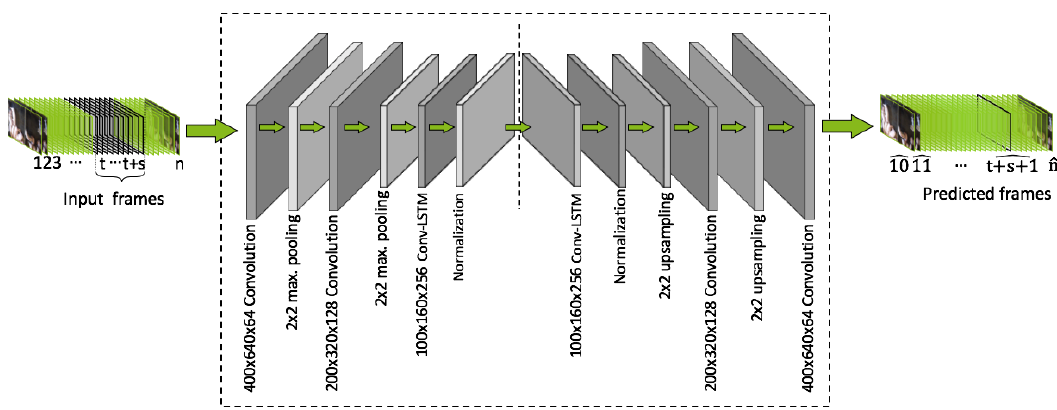
Figure 3. The proposed method uses an hourglass-shaped network to first encode the sequence of input frames to a latent representation of reduced dimension and to predict the next frame. The prediction is then decoded to the input dimension by the spatial decoder and compared to the ground truth images. For each layer, the current dimension of the input frame is indicated by the number in front of the layer